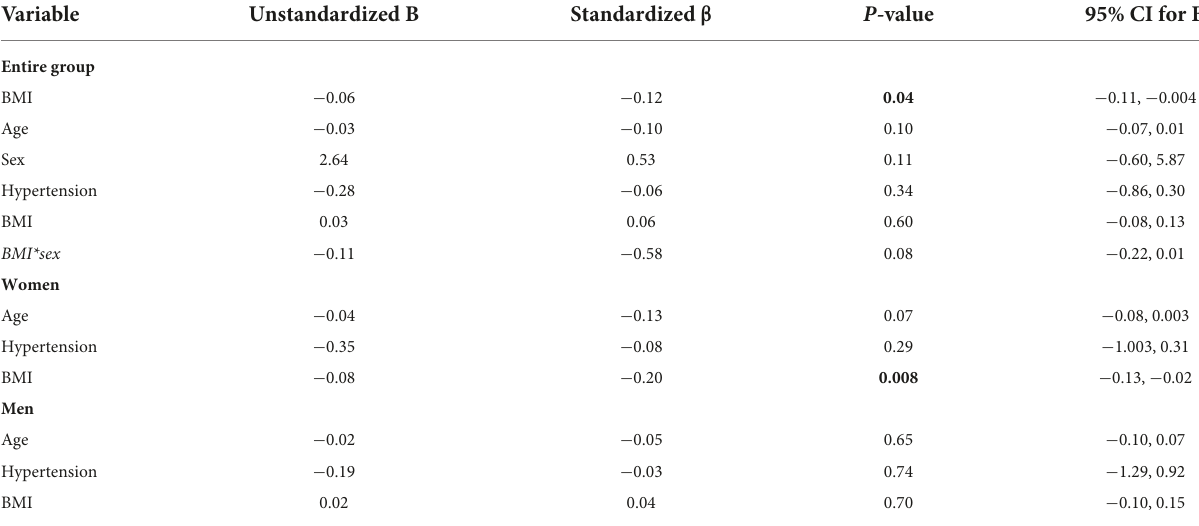
TABLE 2 Linear regression models predicting hippocampal CVR CO2 in the entire group and among women and men separately. Variable Unstandardized B Standardized β